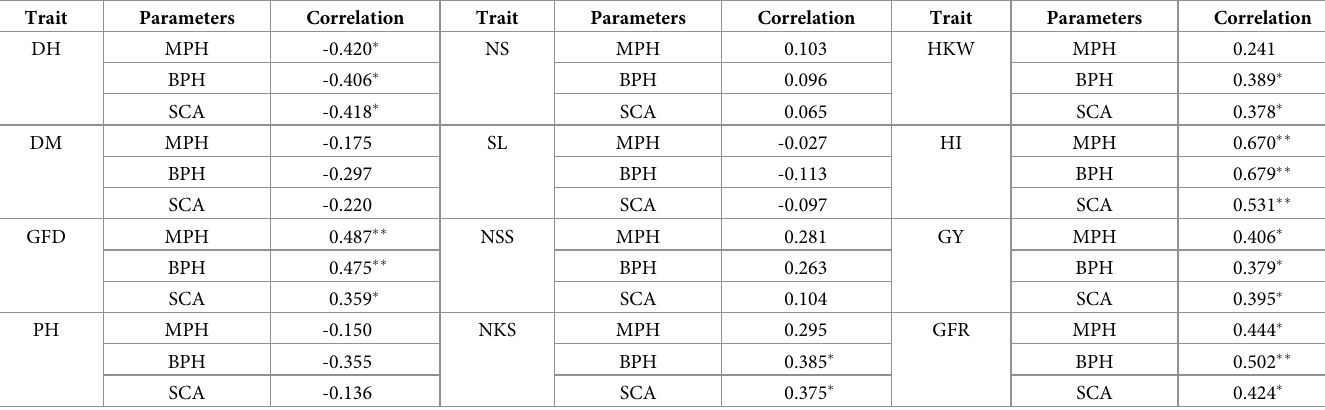
Table 6. Pearson correlation coefficient of GD with MPH, BPH, and SCA of yield and yield-related traits for combined data across seasons.